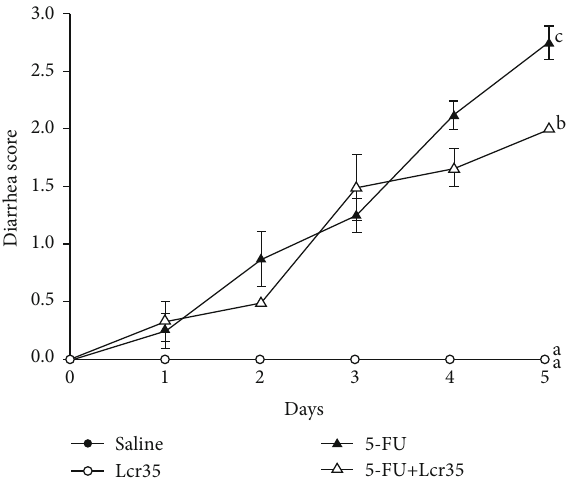
Figure 2: Diarrhea score change in saline- or 5-FU-injected mice with/without probiotic Lcr35 administration. The mice were recorded daily, and the results of all groups were compared with those in the 5-FU+saline group for 5 days. In the control groups, the mice were injected with saline and administrated with saline or Lcr35. In the experimental groups, the mice were injected with 5-FU and administrated with or without Lcr35. Diarrhea scores increased from the 1 st day after 5-FU treatment. Diarrhea scores of the 5-FU+Lcr35 group ( 2 : 00 ± 0 : 00 ) signi fi cantly decreased when compared to those of the 5-FU group ( 2 : 75 ± 0 : 14 ) ( p = 0 : 001 ). The severity of diarrhea was attenuated after probiotic administration in the 5-FU+Lcr35 group. Statistical analysis was performed by one-way